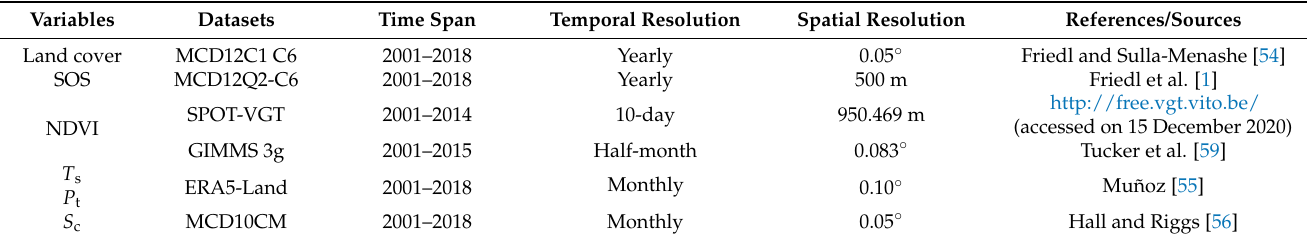
Table 1. Summary of datasets used in this